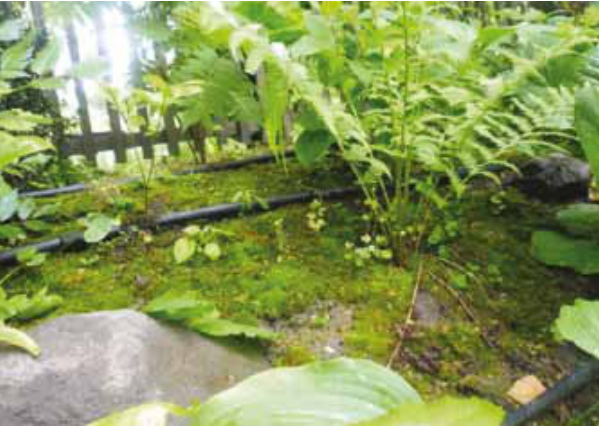
Figure 5. Moss-colonies from mixed mixture with 16 species (photo by F ülöp -p ocsai , 2014)